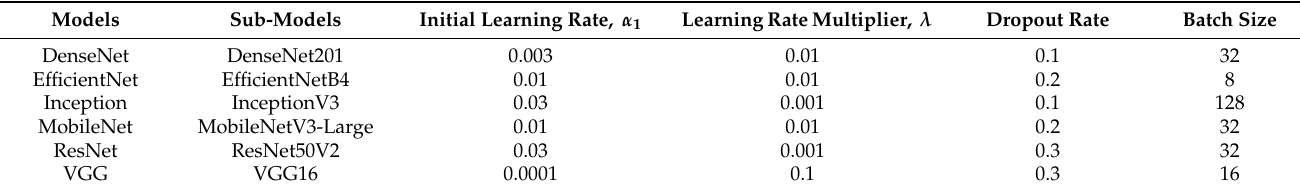
Table 6. Optimal hyperparameter values for each model.